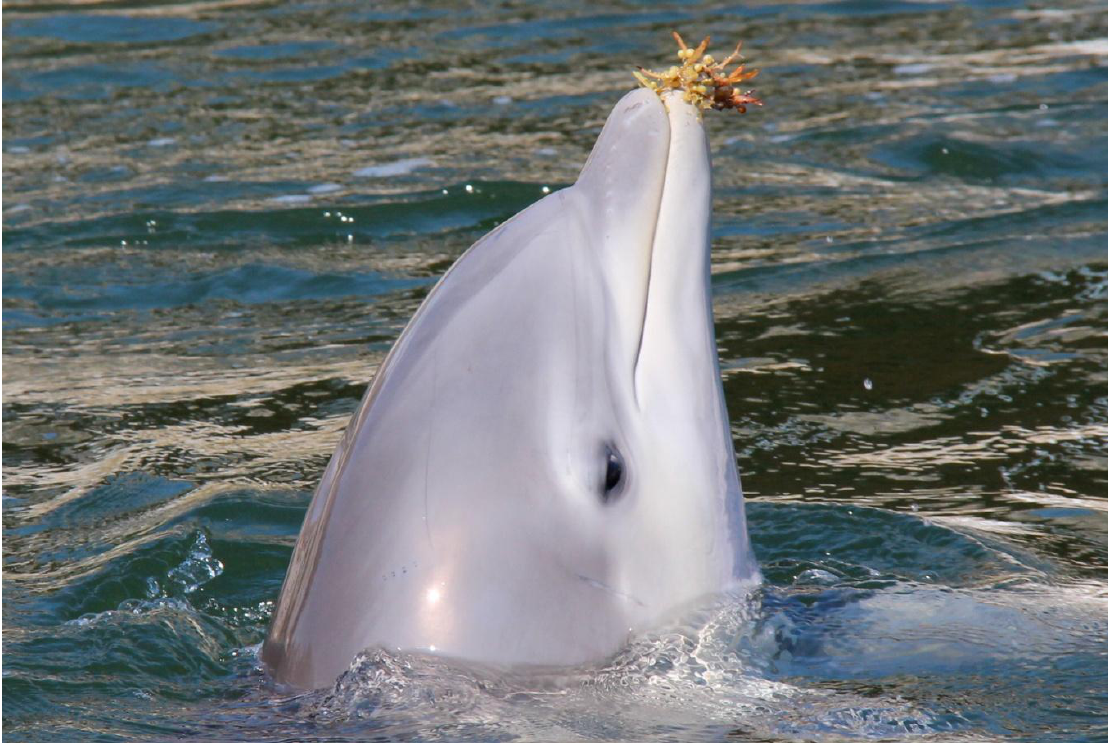
Figure 1. A five-month-old dolphin calf plays with a piece of sargassum ( Sargassum muticum